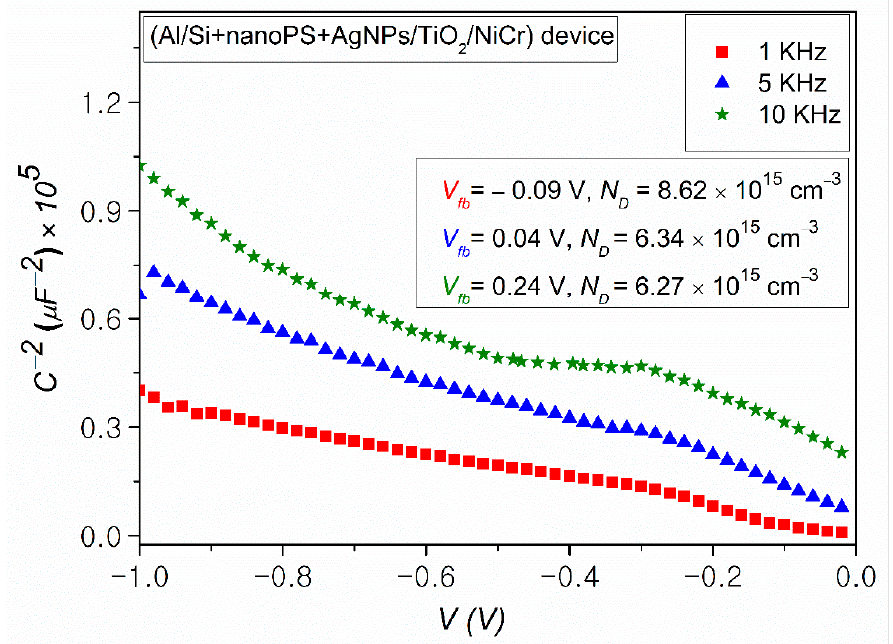
Figure 8. Mott–Schottky diagram for the Al / Si + nanoPS + AgNPs / TiO 2 / NiCr Schottky junction device, at 1, 5, and 10 kHz. The inset shows the values of V fb and N D